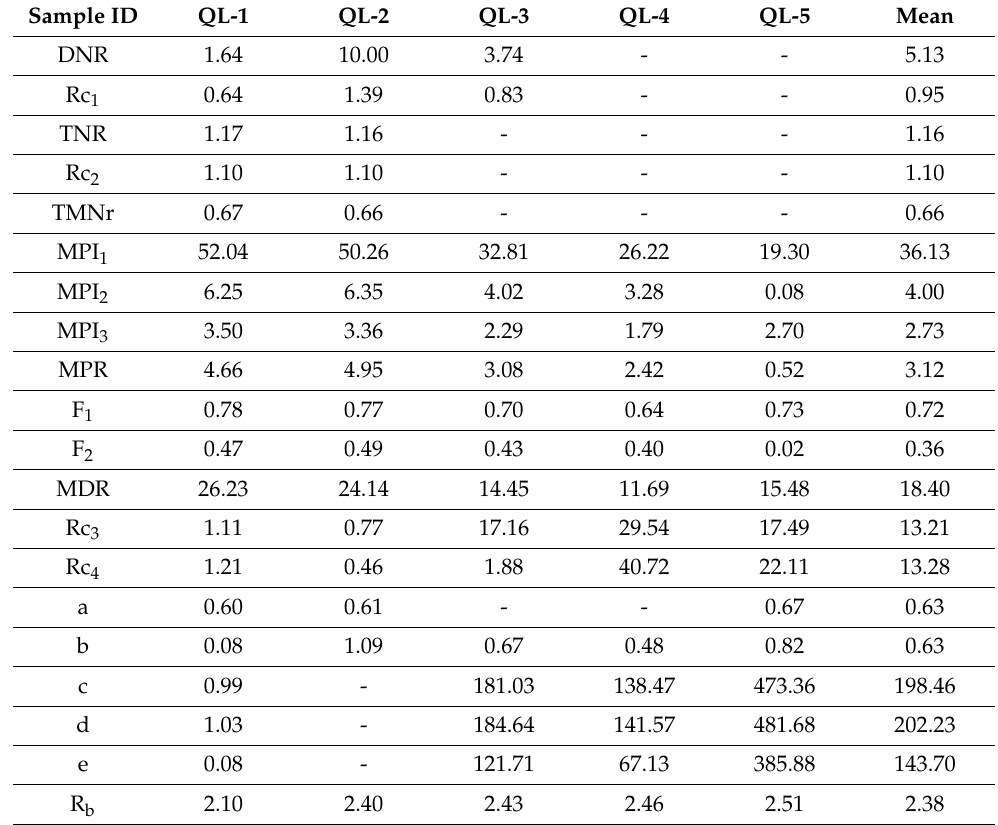
Table 1. The maturity parameters of aromatic compounds in bitumen samples from Qinglong paleo-oil